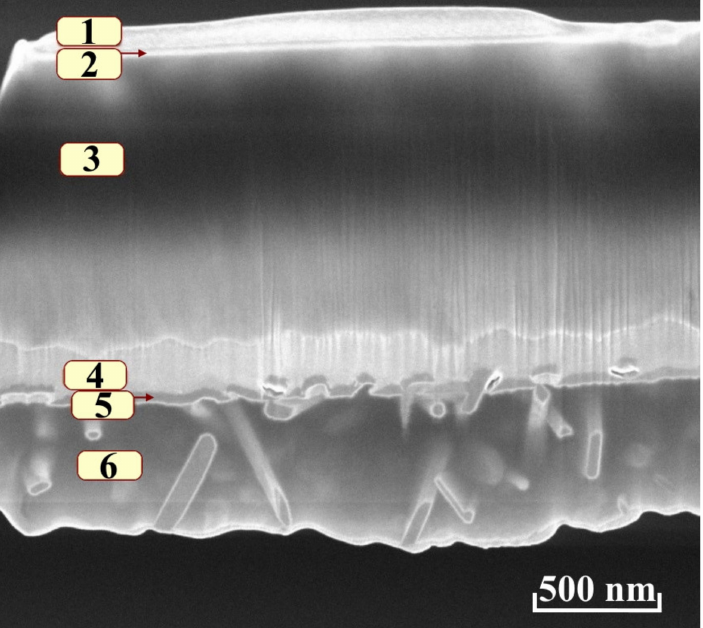
Figure 11. Cross-section of the lamella after thinning: 1—platinum; 2—amorphous layer of AlN; 3—AlN; 4—aluminum; 5—vanadium; and 6—ceramic substrate